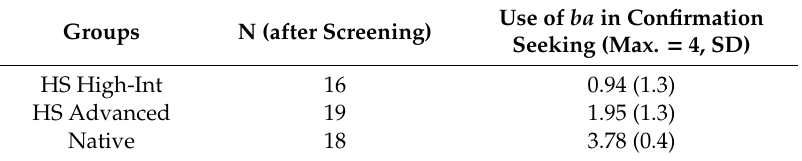
Table 5. Mean scores of all groups in the DCT concerning the [confirmation seeking] feature of the question SFP